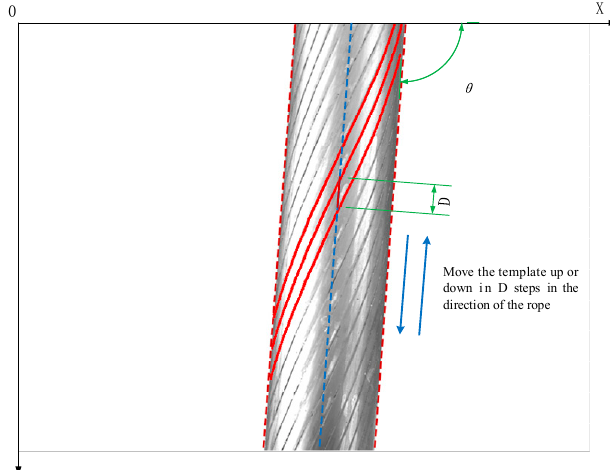
Figure 7. Explanation of shift operation.